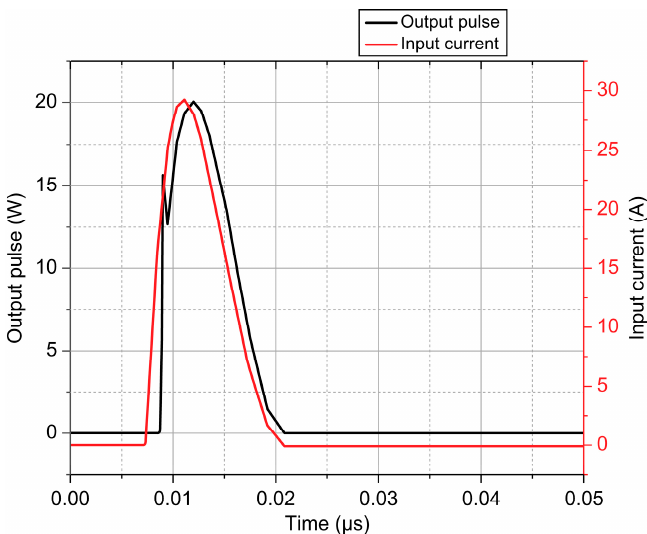
Figure 6. Fundamental circuit of the driver’s power supply based on GaN FET.